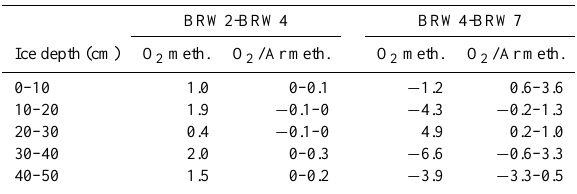
Table 3. NCP in the impermeable ice layers (0 to 50cm depth) from BRW2 to BRW4 and from BRW4 to BRW7, in µmolO 2 L − 1 d − 1 . The columns entitled “O 2 meth.” refer to the NCP derived from the standing stocks of [O 2 ] in bulk ice, while the columns entitled “O 2 /Ar” refer to the NCP derived using the O 2 /Ar (see Eqs. 2 and 3, considering 500 to 3000% of supersaturation). The latter could be further affected by a maximum uncertainty of 35% (see Sect. 4.6.2). BRW2-BRW4 BRW4-BRW7 Ice depth (cm) O 2 meth. O 2 /Ar meth.